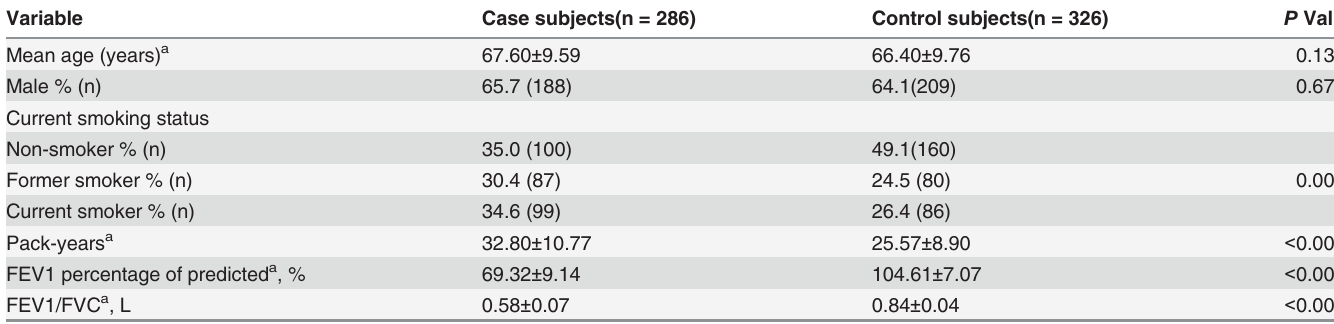
Table 1. Characteristics of COPD patients and healthy